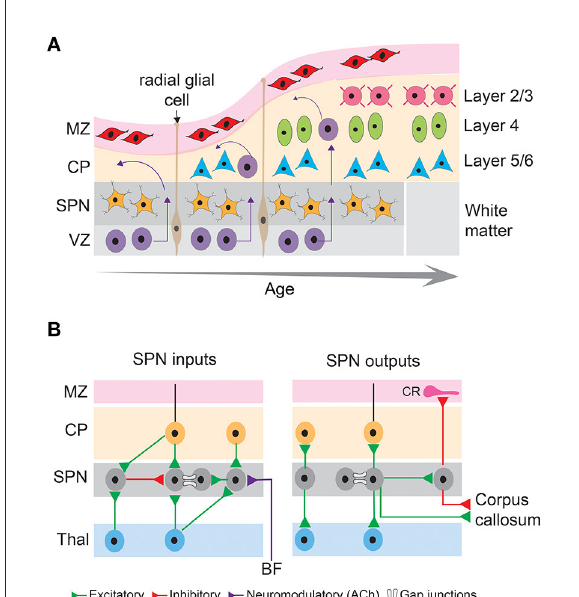
FIGURE2 Basic principles of neocortical development and connectivity of subplate neurons. (A) Schematic diagram showing sequential generation of cortical layers. The earliest cohort of generated neurons comprises subplate neurons and cells in the marginal zone. Later generated neurons being born in the ventricular zone migrate along the processes of radial glial cells toward the pial surface and differentiate into different layers of the cortical plate, thus establishing the inside first-outside last orientation of the cortical layers. MZ, marginal zone; CP, cortical plate; SPN, subplate neurons; VZ, ventricular zone. (B) Schematic diagram showing inputs and outputs of subplate neurons that comprise excitatory (green), inhibitory (red) and neuromodulatory (purple) connections as well as gap junctional coupling. CR, Cajal-Retzius neuron; BF, basal forebrain; Thal,